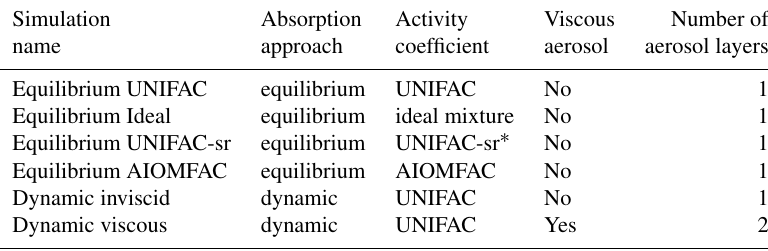
Table 3. List of the sensitivity simulations using different options in SOAP. Simulation Absorption Activity Viscous Number of name approach coefficient aerosol aerosol layers Equilibrium UNIFAC equilibrium UNIFAC No 1 Equilibrium Ideal equilibrium ideal mixture No 1 Equilibrium UNIFAC-sr equilibrium UNIFAC-sr ∗ No Equilibrium AIOMFAC equilibrium AIOMFAC Dynamic inviscid dynamic UNIFAC Dynamic viscous